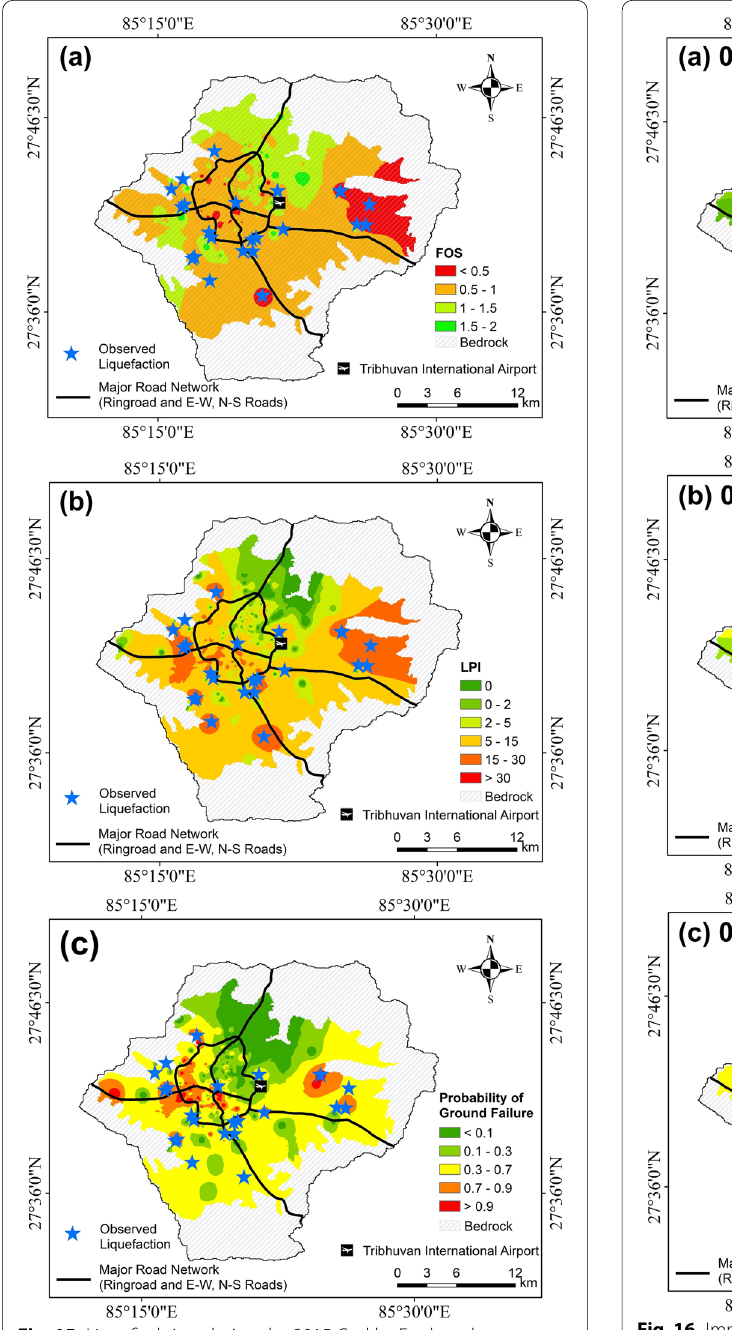
Fig. 15 Liquefied sites during the 2015 Gorkha Earthquake presented in a FOS, b LPI, and c P G maps of Kathmandu Valley prepared for earthquake scenario of M w 7.8 (0.18 g)